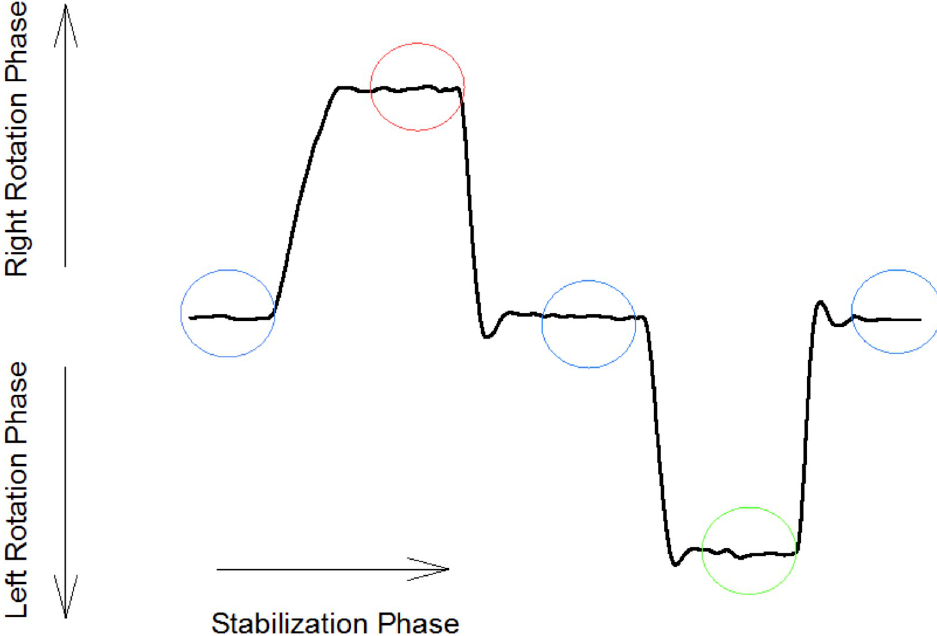
Fig 2. Typical trace recorded during head rotations. Head rotations phases are visualized by the ascendant/ descendant phase of the solid line and stabilization phases are visualized by the horizontal phase of the solid line. Blue circles are for center target. Red circle is for right target. Green circle is for left